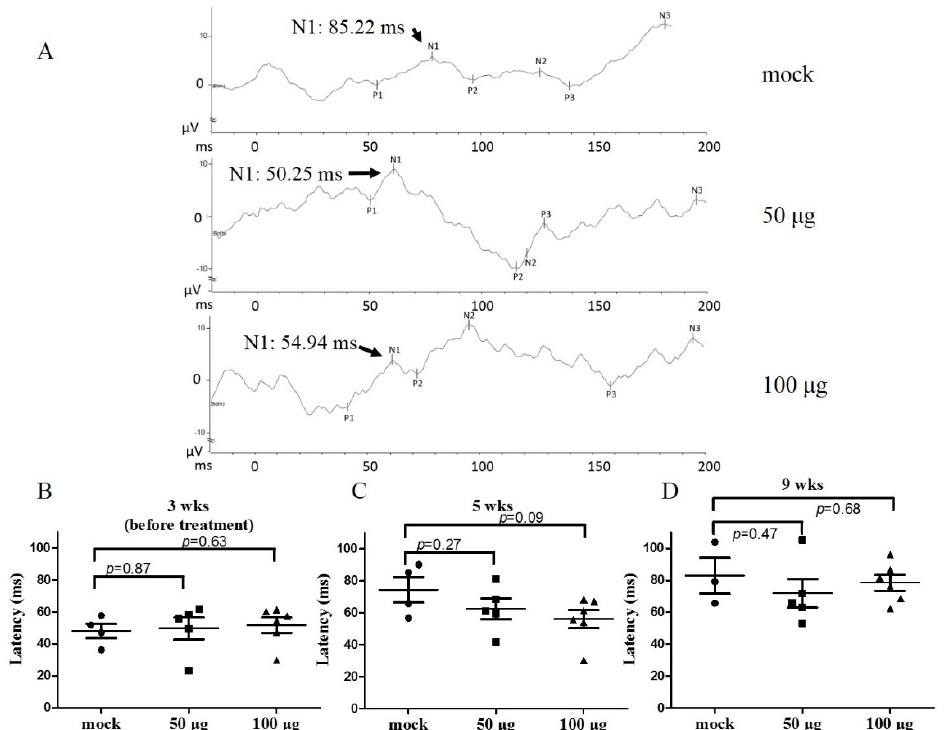
Figure 5. VEP recording of RCS rats after mitochondrial transplantation. ( A ) Representative VEP waveforms in the control rat and mitochondria-treated groups at 5 weeks of age. ( B – D ) The summary of the timing of VEP N1 latency in the control rat and mitochondria-treated groups at 3 ( B ), 5 ( C ), 9 weeks ( D ) of age. VEP: visual evoked potential.